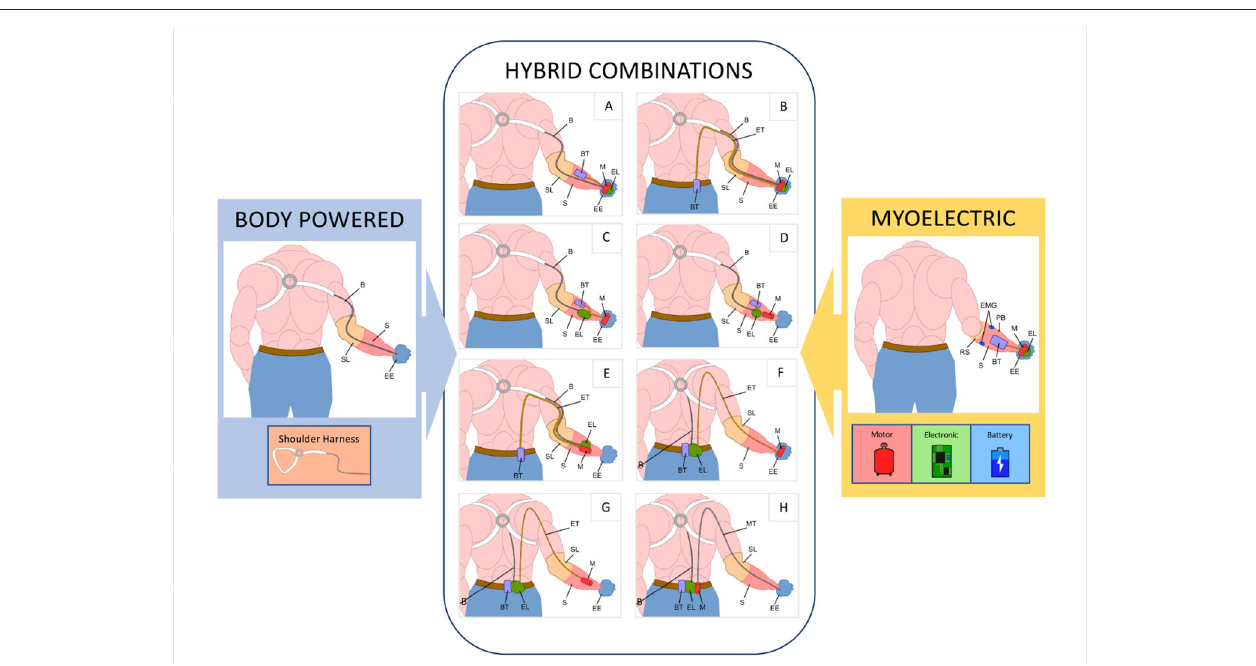
FIGURE 1 | The typical set-up of a body-powered prosthesis (using a figure-of-nine harness) is shown on the left and a typical myoelectric prosthesis on the right. The input and terminal device components highlighted in the inset are combined in hybrid systems. Main components: EE, Prosthetic Device; S, Socket; RS, Rigid Socket; SL, Soft Socket Liners; B, Cable Control System; EMG, Surface Electromyographic Sensors; M, Motors; EL, Electronic Boards; BT, Battery Pack; PB, Power Button; ET, Electrical Transmission Cable; MT, Flexible Transmission Shaft.